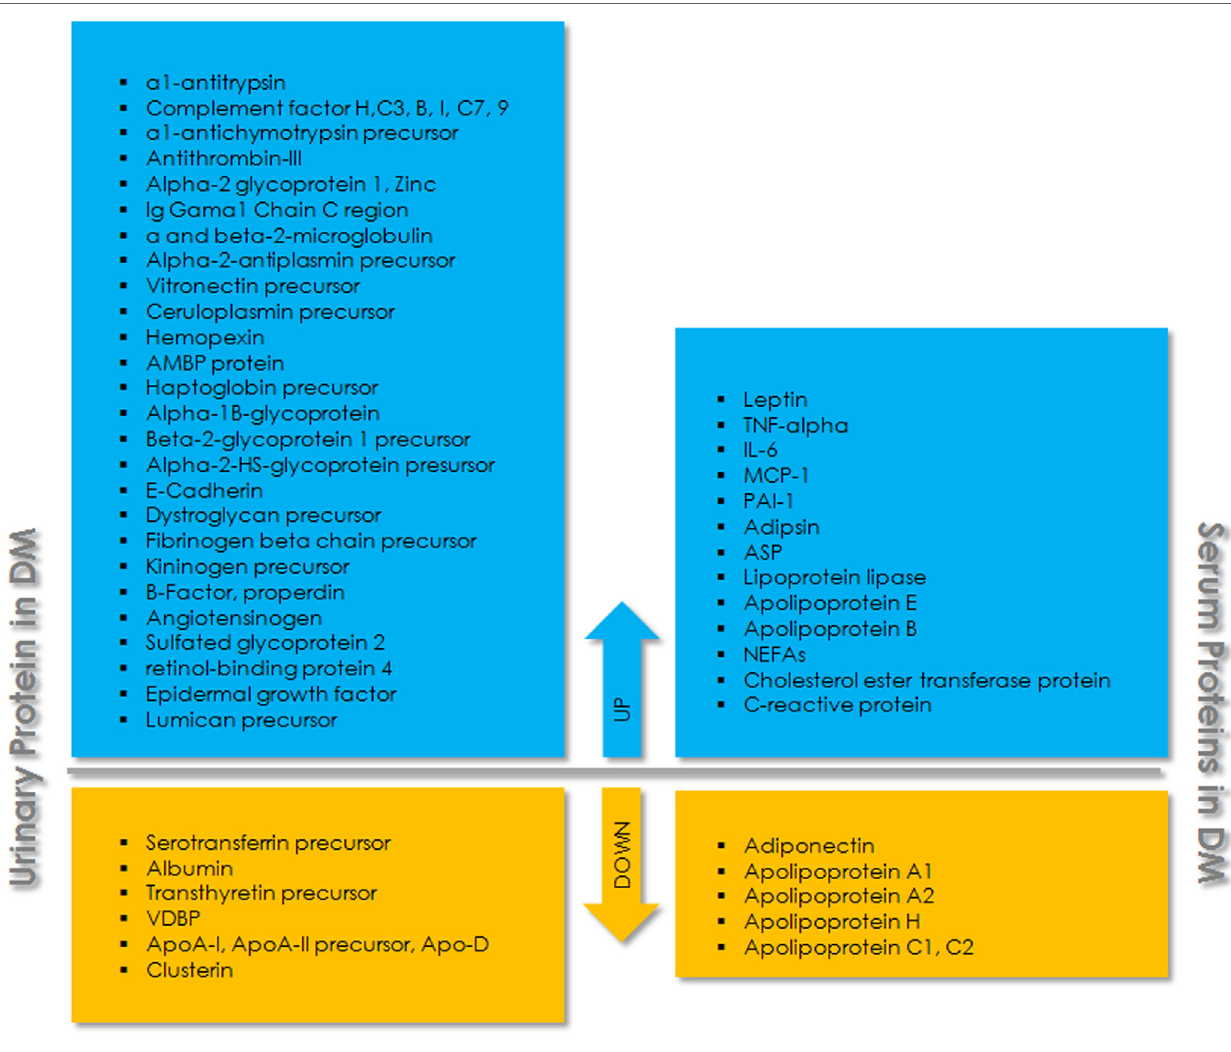
FiGURe 1 | Schematic overview of urinary and serum proteins associated with type 2 diabetes mellitus (T2DM). The upper panel (blue) indicates upregulated proteins and the lower panel (yellow) indicates downregulated proteins in urine and